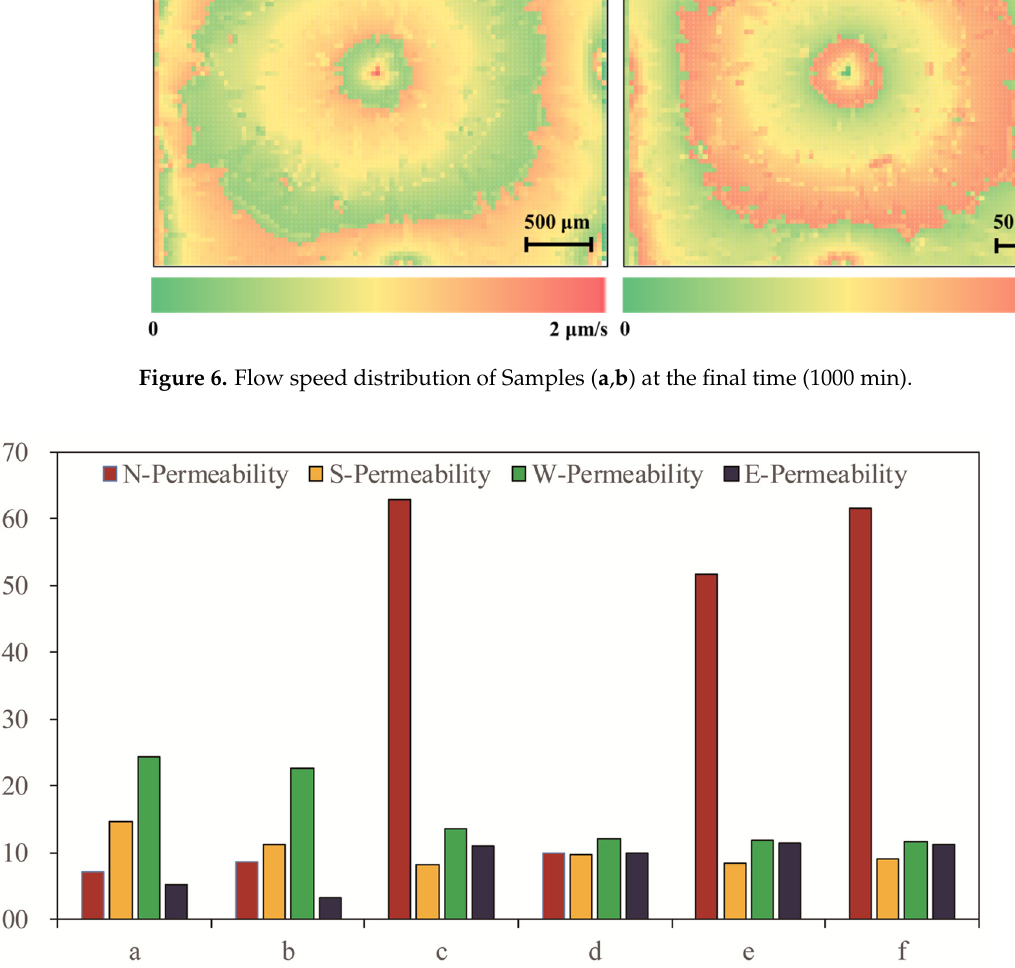
Figure 8. Variability coefficient, penetration coefficient, and gradient statistics of two-dimensional permeability of samples a–f. The frequency statistics of flow direction in six samples of tight reservoir are carried out, and cumulative probability distribution curves are constructed (Figure 9). According to the distribution characteristics of the frequency statistics histogram, the distribution of flow direction can be classified into five types: single peak-single column type, single